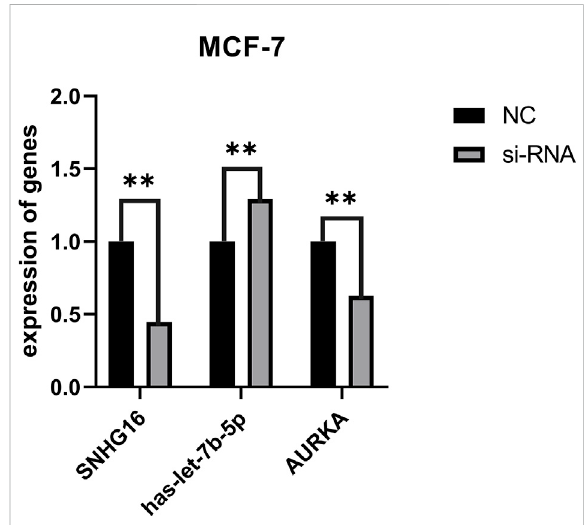
FIGURE 8 Changes in ceRNA genes after knockdown of SNHG16. The horizontal coordinates represent SNHG16, hesa-let-7b-5p and AURKA before and after transfection, respectively. The vertical coordinates represent gene expression; black represents the expression of control genes and grey represents the expression of genes after transfection. ** p <